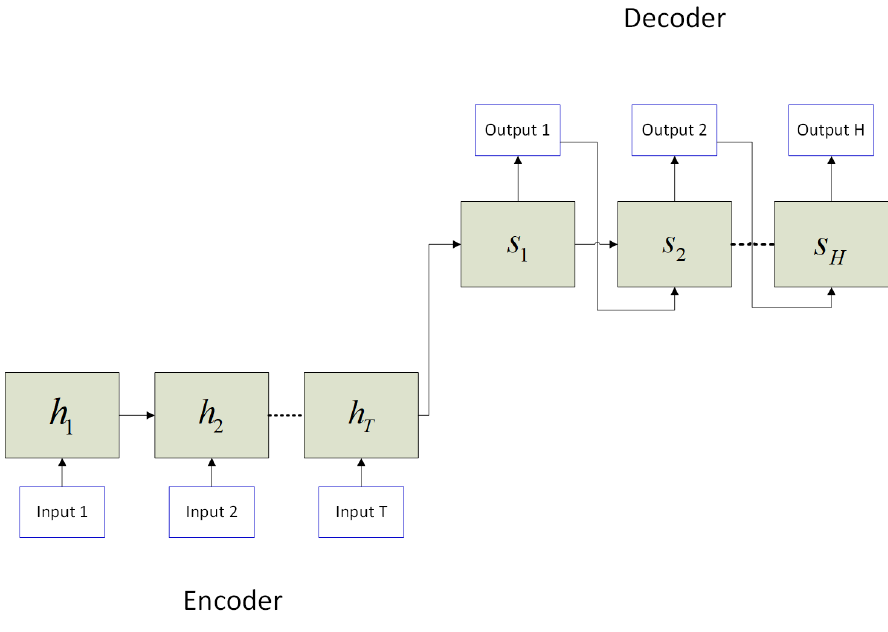
Figure 1. Sequence-to-sequence RNN